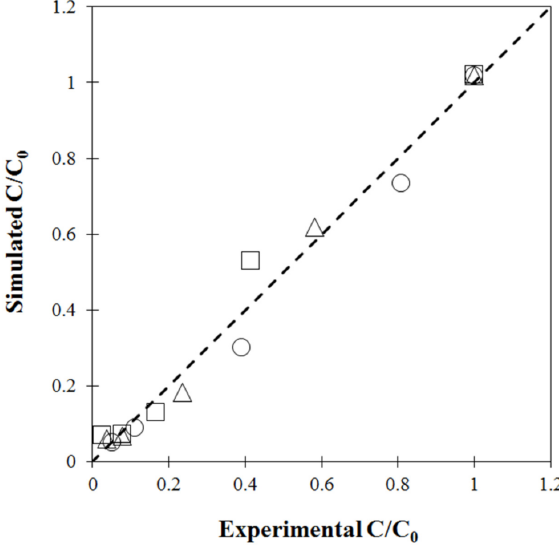
Figure 9. Validation of β -carotene ratio at different drying temperatures: circle (60 ◦ C), triangle (70 ◦ C) and square (80 ◦